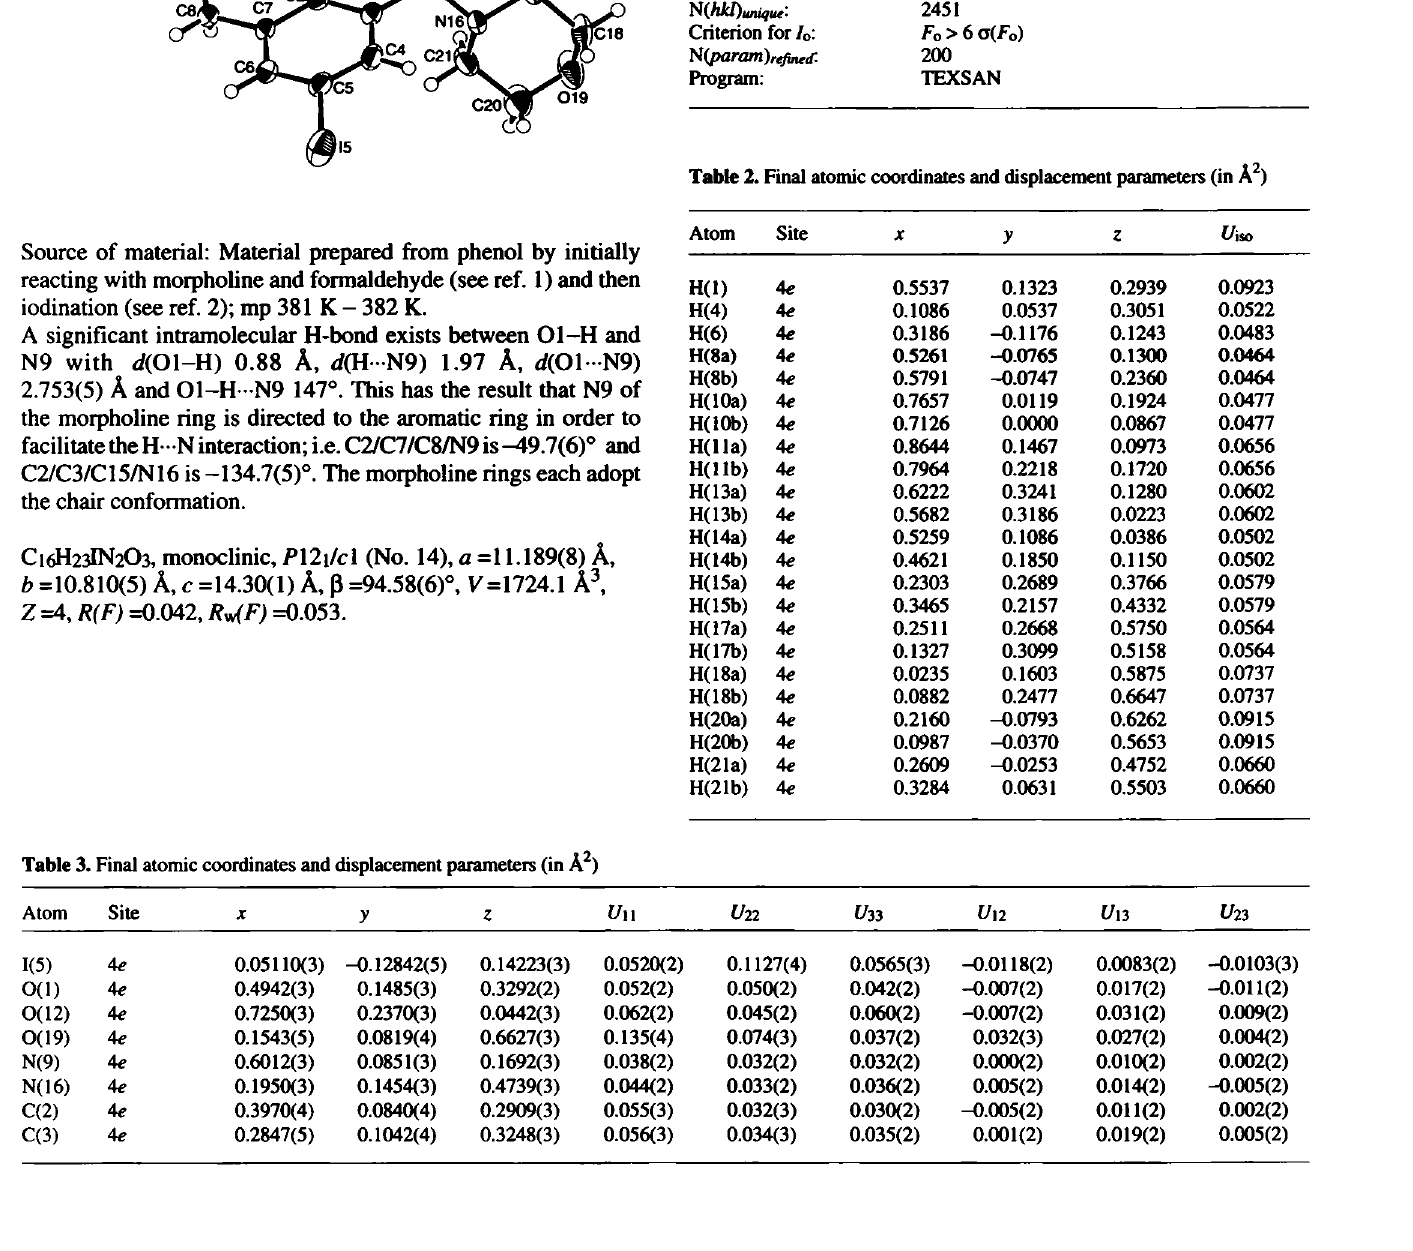
Table 1. Parameters used for the X-ray data collection